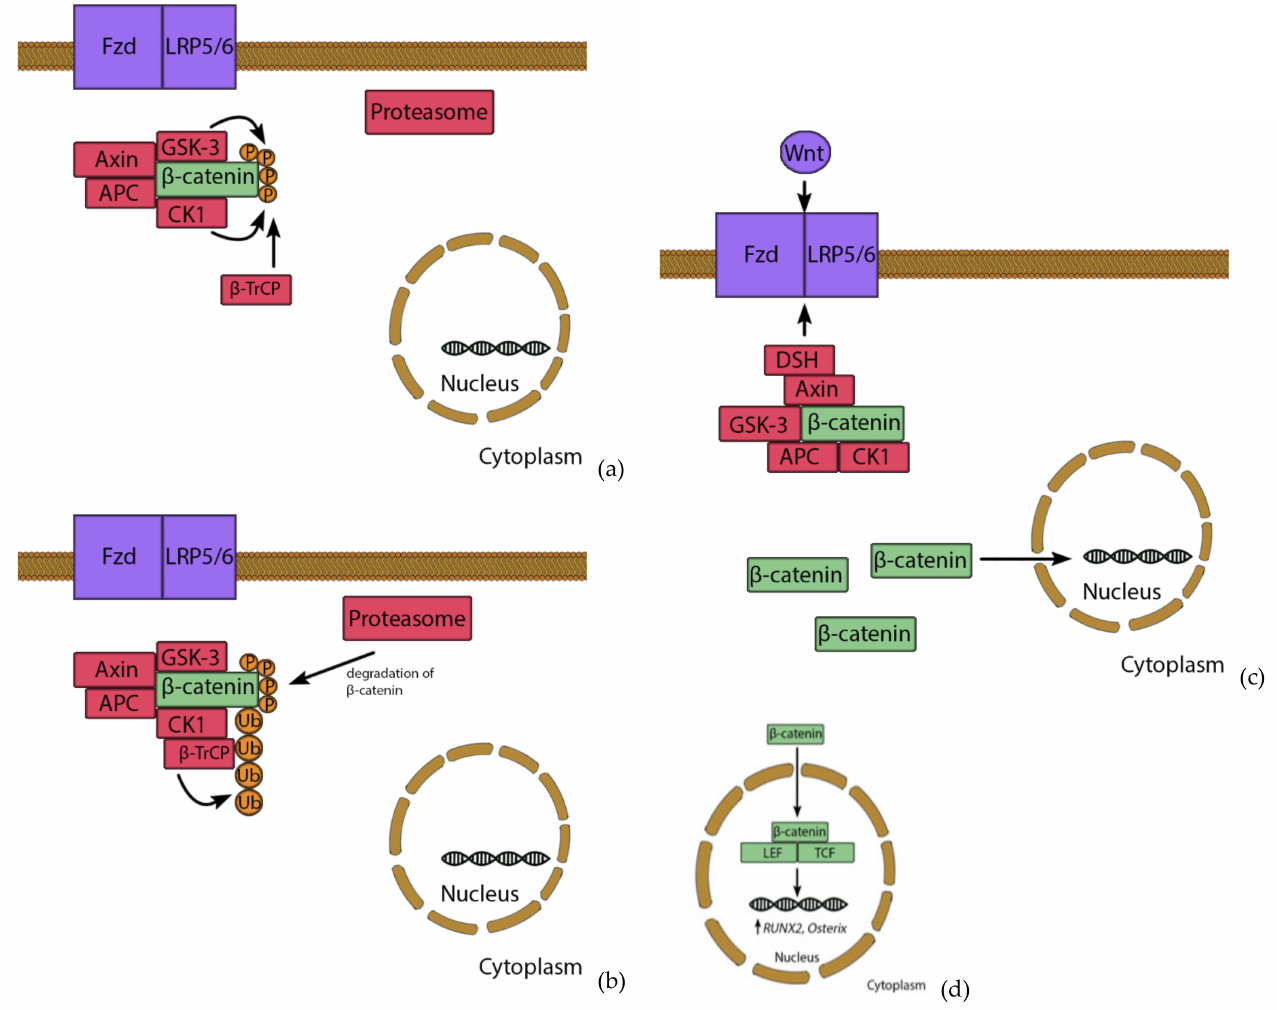
Figure 3. Wnt/ β -catenin pathway. Under basal conditions, β -catenin is bound by a removal complex consisting of Axin, GSK-3, APC and CK1 ( a ). GSK-3 and CK-1 marked β -catenin though phosphorylation, which recruits β -TrCP. β -TrCP leads to ubiquitination and degradation of β -catenin ( b ). However, stimulation of Wnt leads to activation of disheveled proteins (DSH), which binds the removal complex to the receptor. Therefore, β -catenin is not degraded and can enter the nucleus ( c ), where it forms a complex with TCF and LEF transcription factors. This complex induces expression of e.g., RUNX2 and Osterix , leading to osteogenic differentiation ( d